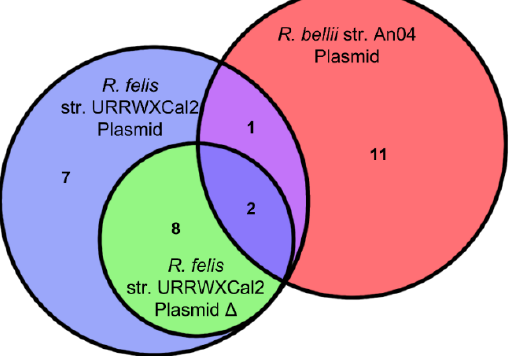
Figure 2. The overlap of predicted effectors between the three analyzed rickettsial plasmids.